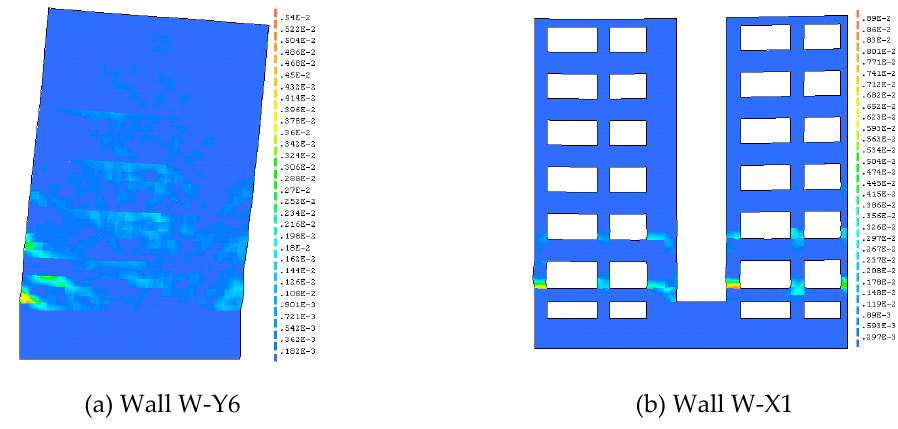
Figure 10. ( a ) Damage of the perpendicular wall; ( b ) longitudinal wall due to 0.2 g scaled accelerogram.